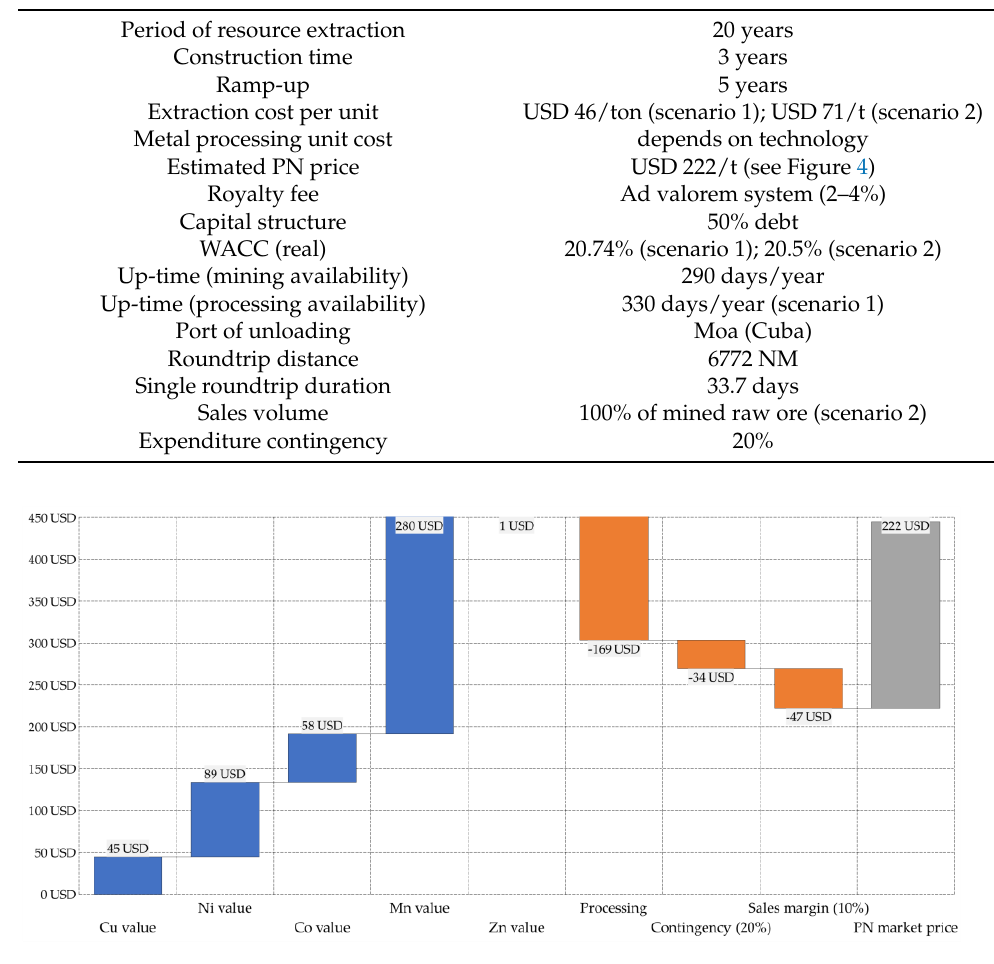
Figure 7. The results of the economic analysis (accumulated cash flow) of scenario 1—PM, FCFF—free cash flow for the firm, dFCFF—discounted FCFF (QVISTORP growth, QVISTORP calculation). Figure 8. The results of the economic analysis (accumulated cash flow) of scenario 1—HPAL, FCFF—free cash flow for the firm, dFCFF—discounted FCFF (QVISTORP growth, QVISTORP calculation).